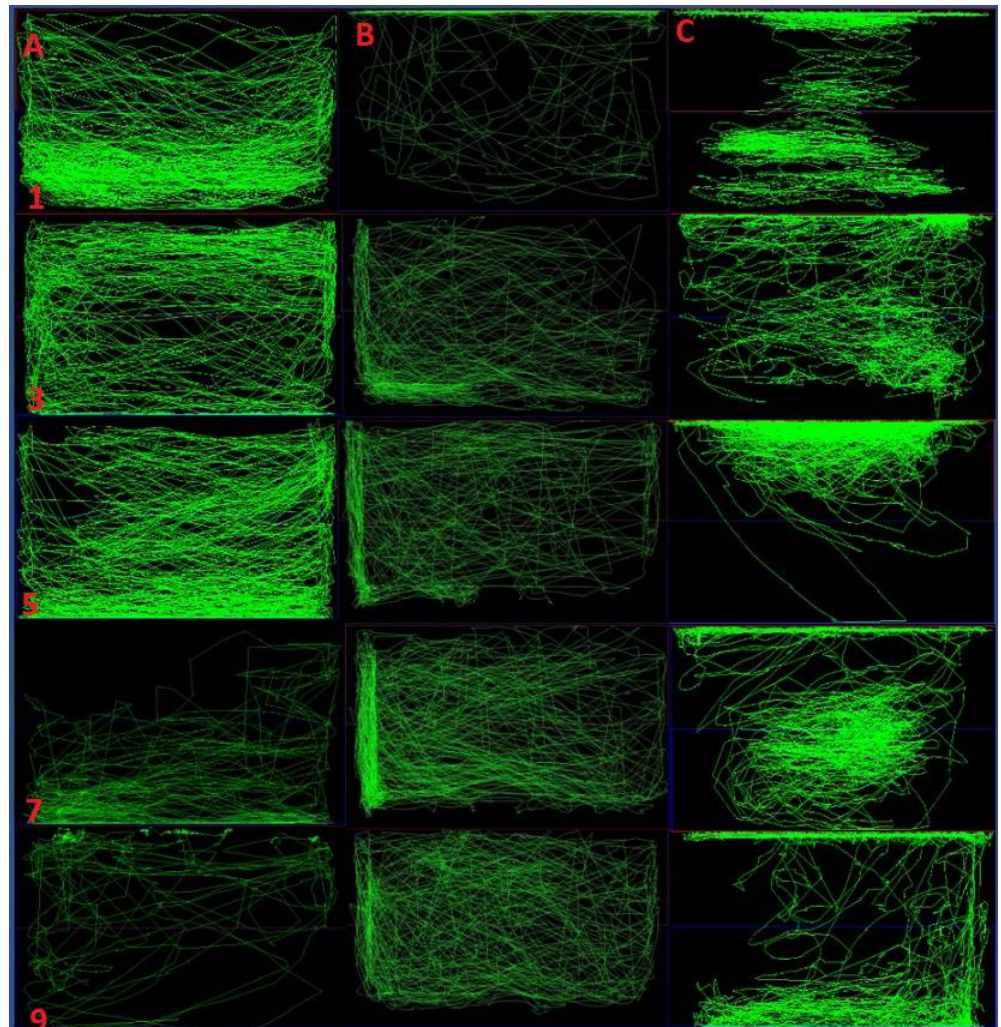
Figure 5. Comparison of locomotor pattern and behavior of fish. Single dose and repeated dose of pilocarpine treatment versus normal control. Representative swimming patterns (behavior recording) for the corresponding three experimental groups ( A – C ). The swimming pattern for the group ( A ) represents the 10% DMSO only vehicle control. The swimming pattern for the group ( B ) represents the single dose of Pilocarpine (400 mg/kg) whereas the swimming pattern for the group ( C ) represents the repeated dose of Pilocarpine (400 mg/kg) for 10 days. The number in the rows represents the swimming pattern of the specific day (1, 3, 5, 7, 9).